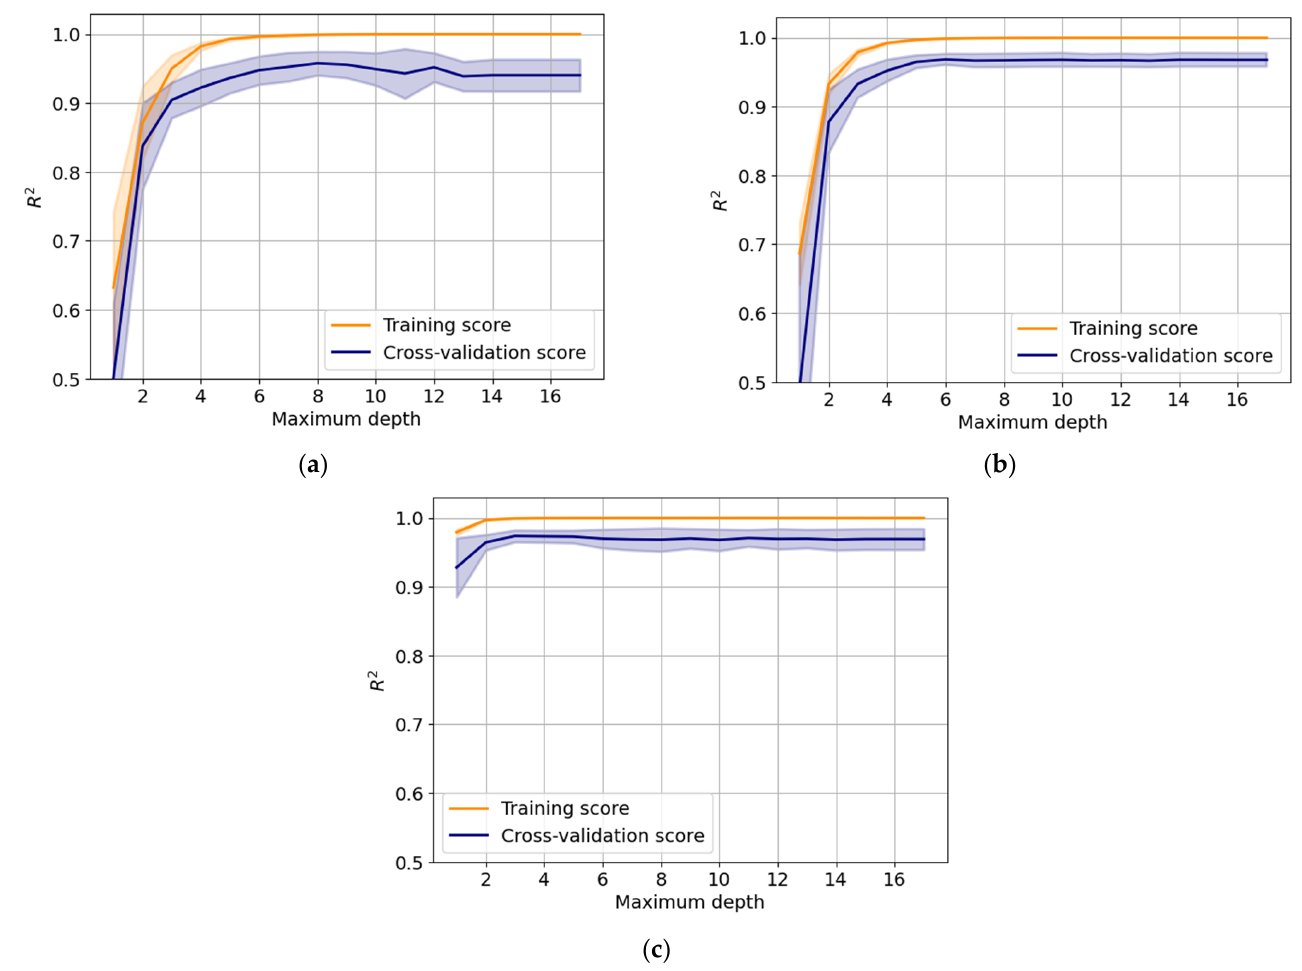
Figure 6. Validation curve for the maximum depth of the trees: ( a ) DT, ( b ) AB and ( c ) GTB.